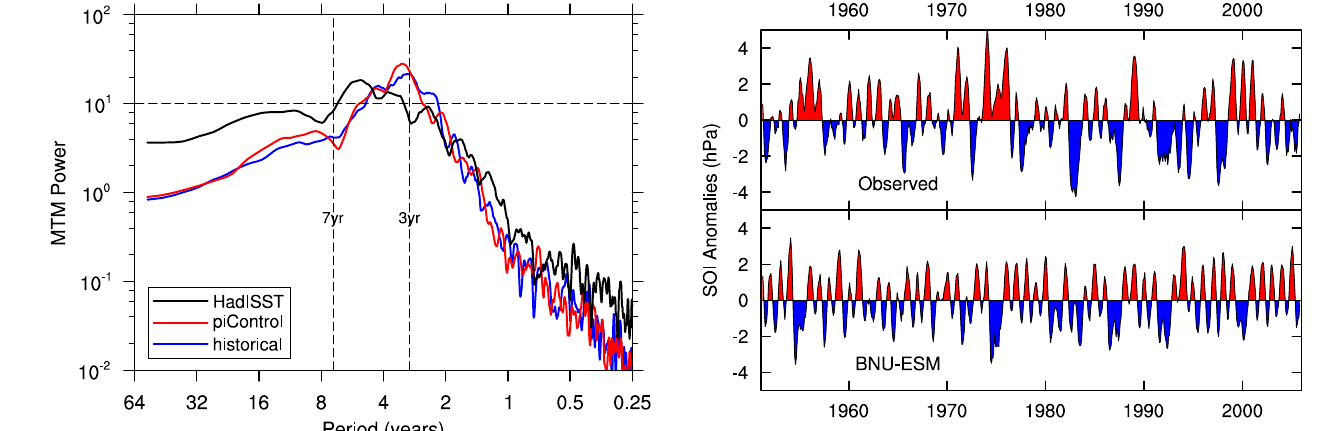
Figure 18. Power spectra of the Niño-3.4 index (the SST anomalies of Fig. 17 normalized with the standard deviation) using the multi- taper method (Ghil et al., 2002) with resolution p = 4 and number of tapers t = 7.